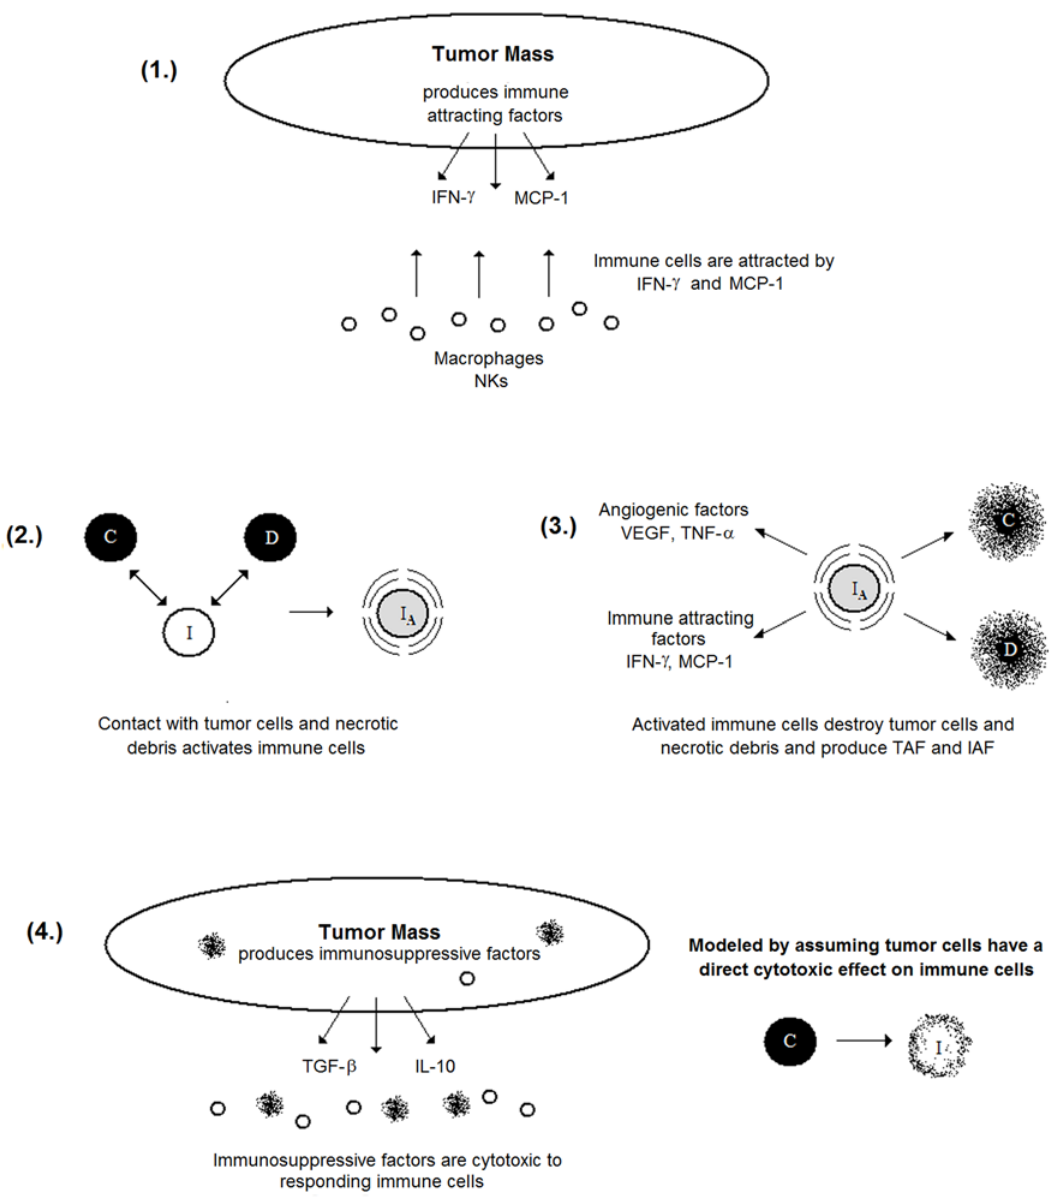
Figure 2. A schematic of the modeled anti-tumor immune response. (1) Cancer cells produce factors that attract immune cells, primarily macrophages and natural killers, to the tumor site. (2) In response to direct contact with either tumor or necrotic cells, immune cells are activated. (3) These activated immune cells kill cancer cells and clear necrotic debris at an increased rate; they also produce both TAF and IAF, enhancing the immune response while potentially inducing angiogenesis. (4) The tumor microenvironment is strongly immunosuppressive, and this is modeled by assuming that direct contact with tumor cells is cytotoxic to immune cells.